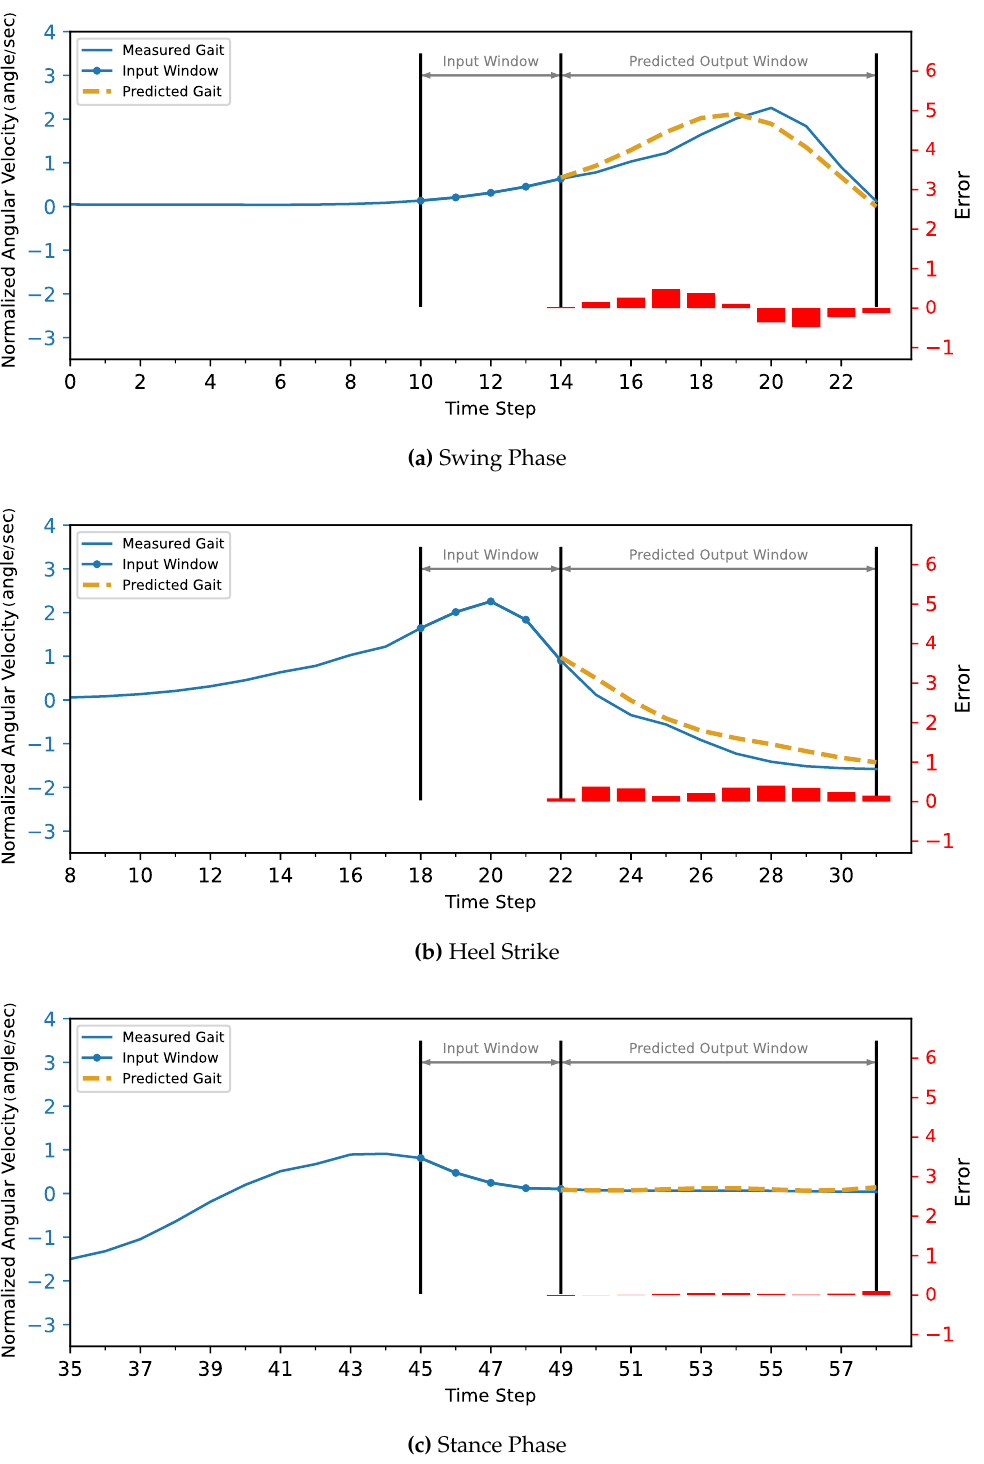
Figure 8. The CNN model without CGP provided 10 time steps ahead prediction for z-score normalized angular velocity of the foot of the inter-subject. The angular velocities are normalized to have zero mean and unit variance. The actual gait is shown in blue, and the predicted trajectory is shown in gold (dashed).